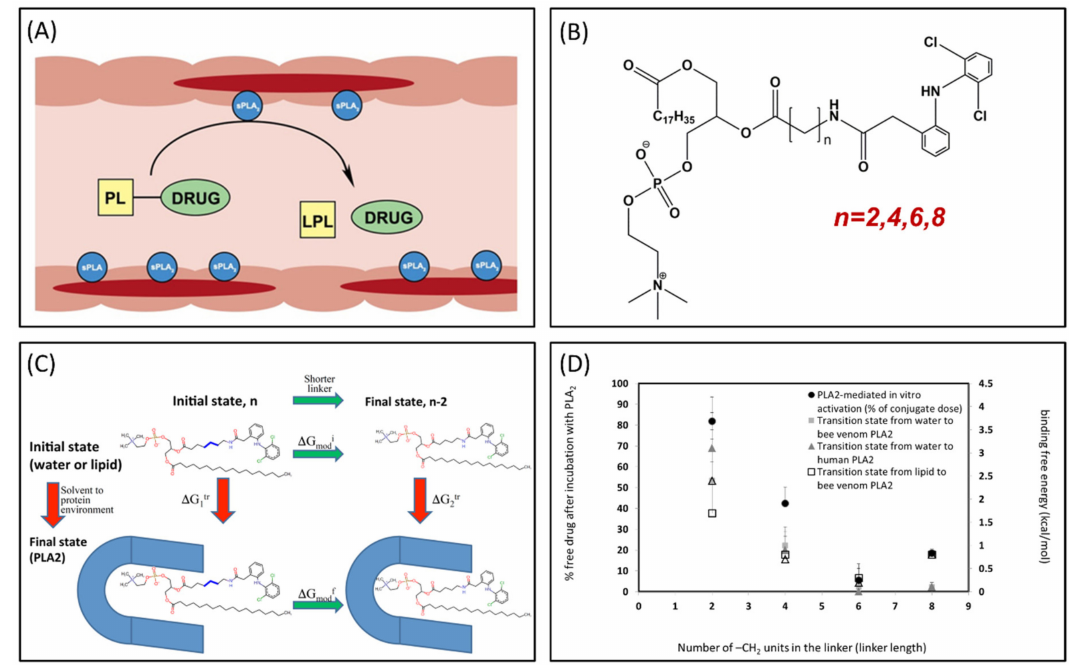
Figure 4. ( A ) Illustration of phospholipid (PL)-prodrug activation in phospholipase A 2 (PLA 2 )-rich inflamed intestinal tissues of Inflammatory Bowel Disease (IBD) patients; ( B ) Structure of PL-diclofenac prodrug; ( C ) Thermodynamic cycle used for relative binding free energy calculations of PL-diclofenac prodrugs in the transition state complex of PLA 2 ; and ( D ) In vitro / in silico correlation: binding free energies in PLA 2 transition state (kcal / mol) vs. in vitro activation for di ff erent PL-diclofenac prodrugs (% of intact complex). Reproduced with permission from